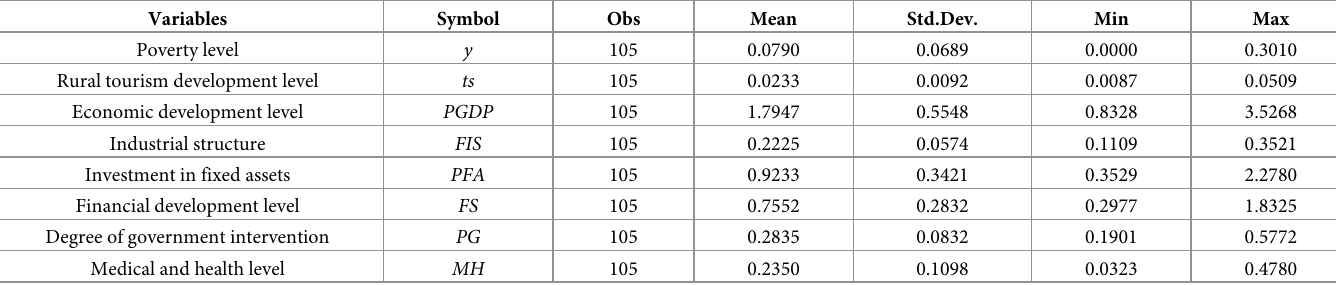
Table 1. Descriptive statistical analysis of